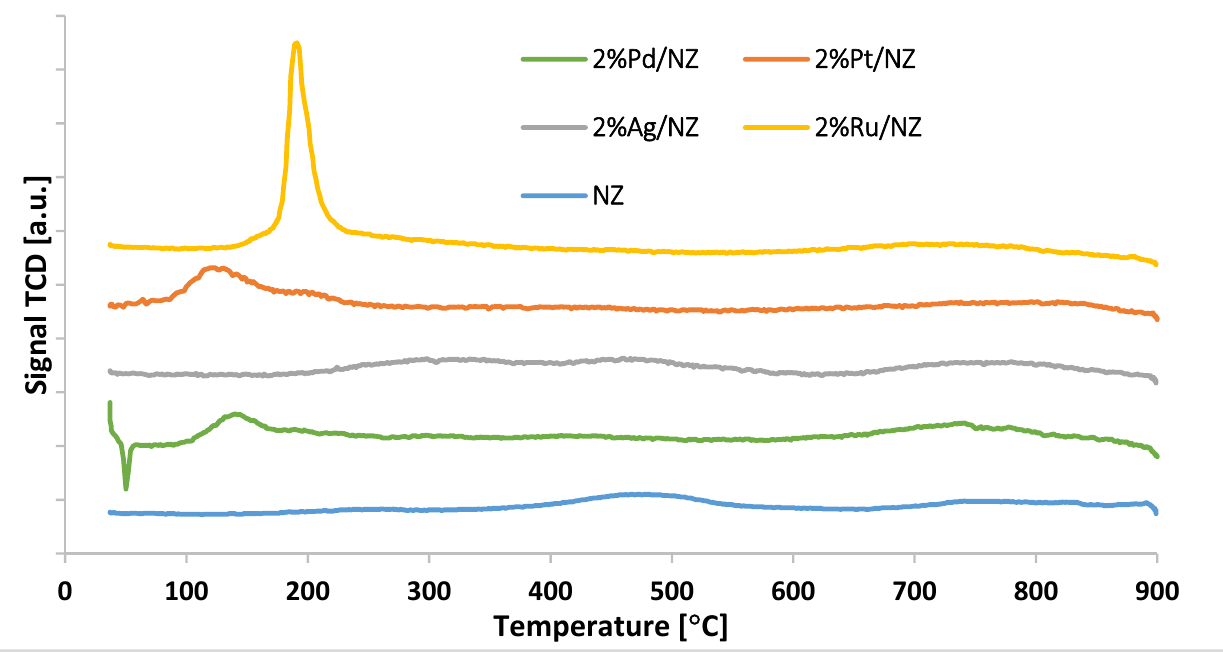
Figure 5. H 2 -TPR curves recorded for NZ and various monometallic catalysts M/NZ (where M = Ag, Pd, Pt, Ru) calcined in an air atmosphere at 400 °C for 4 h.